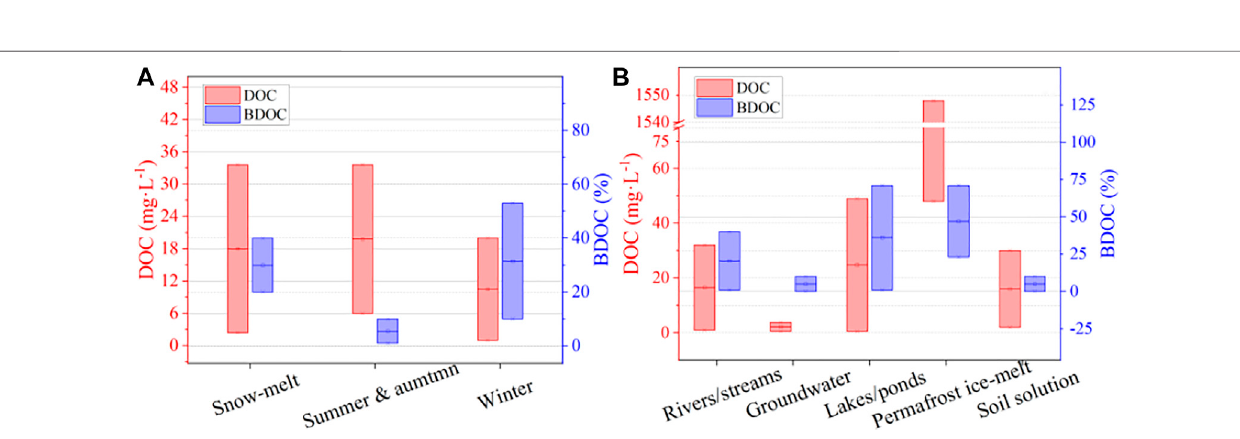
FIGURE 4 | DOC concentrations and biodegradable DOC (BDOC) in aquatic systems in permafrost domains. (A) Seasonal distribution of in-stream DOC and BDOC (Finlay et al., 2006, 2009; Petrone et al., 2006; Holmes et al., 2008; O ’ donnell et al., 2012; Wickland et al., 2012; Olefeldt and Roulet, 2014; Abbott et al., 2014), and (B) DOCand BDOCin variedwatertypes(Vonk etal., 2013,2015b; Abbottet al.,2014; Mann etal., 2015;Selvamet al.,2017;Textoret al.,2019; Payandi-Rolland et al., 2020); Notes: BDOC can be calculated by either incubation experiment (7 – 40 d) (Holmes et al., 2008; Vonk et al., 2013; Abbott et al., 2014; Selvam et al., 2017;Textoretal.,2019)orproxiesofchemicalcompositions,forexample,hydrophiliccompoundsasalabilefractionofDOCmineralization(O ’ Donnelletal.,2012)and tyrosine- and tryptophan-like fl uorophores (Finlay et al., 2006; Guo and Macdonald, 2006; Petrone et al., 2006; Balcarczyk et al.,